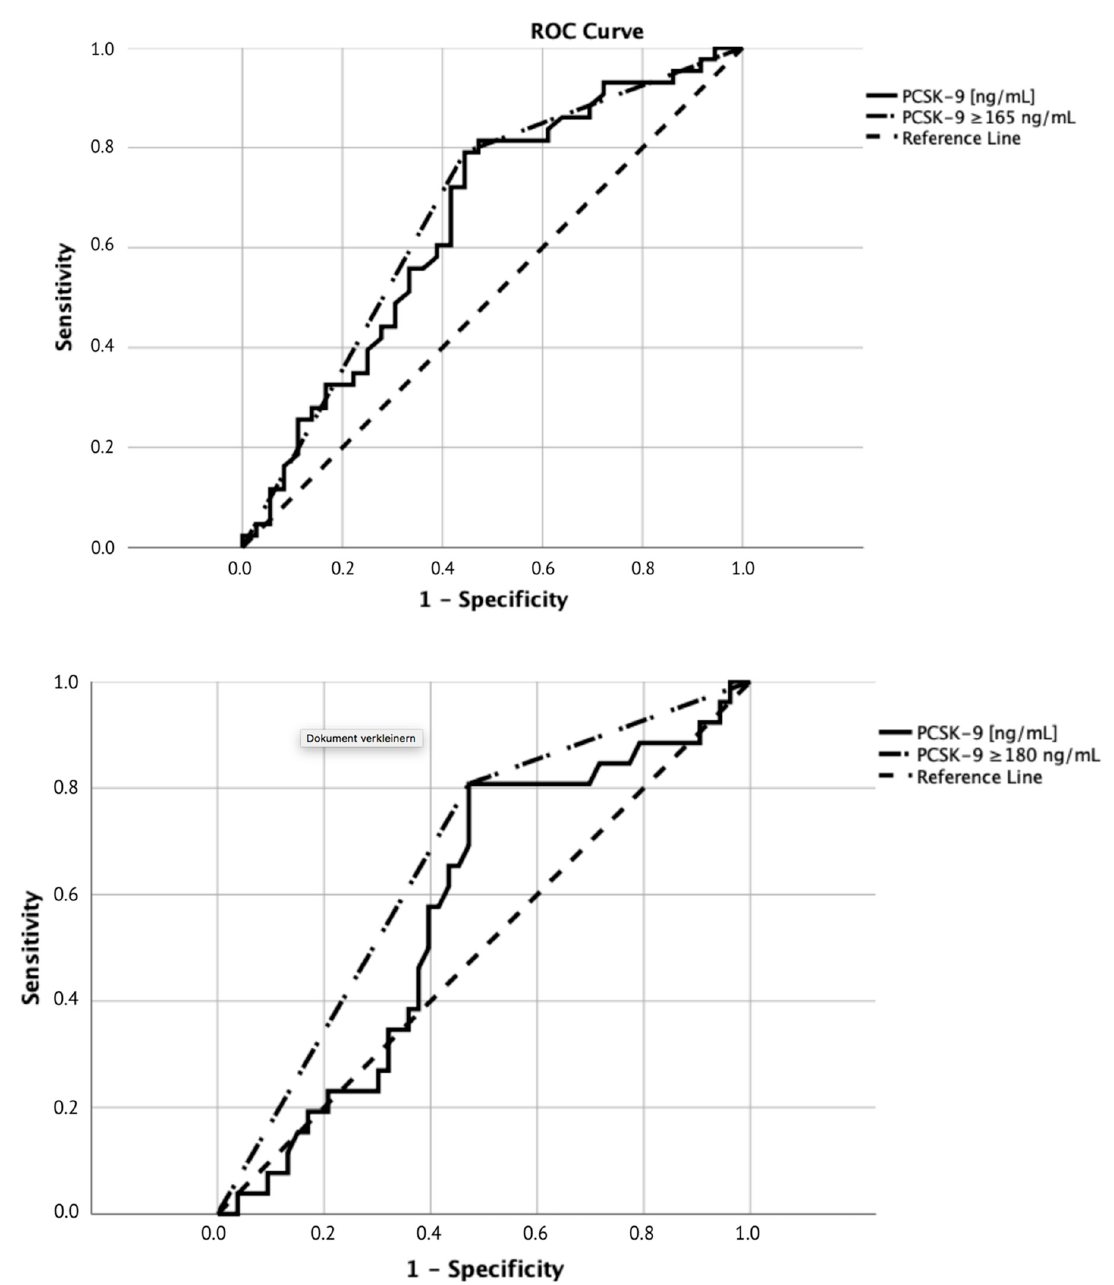
Figure 2. Receiver operating characteristic curve (ROC) analyses. Upper panel: ROC analysis for unfavorable neurologic outcome, the optimal cutoff for PCSK–9 was < 165/ ≥ 165 ng/mL. The area under the curve (AUC) was 0.67 (95% confidence intervals 0.55–0.80). Sensitivity for this cutoff was 79%, while specificity was 56%. Lower panel: ROC analysis for 30 ‐ day mortality, the optimal cutoff for PCSK–9 was < 180/ ≥ 180 ng/mL. The AUC was 0.67 (95% confidence intervals 0.54–0.79).